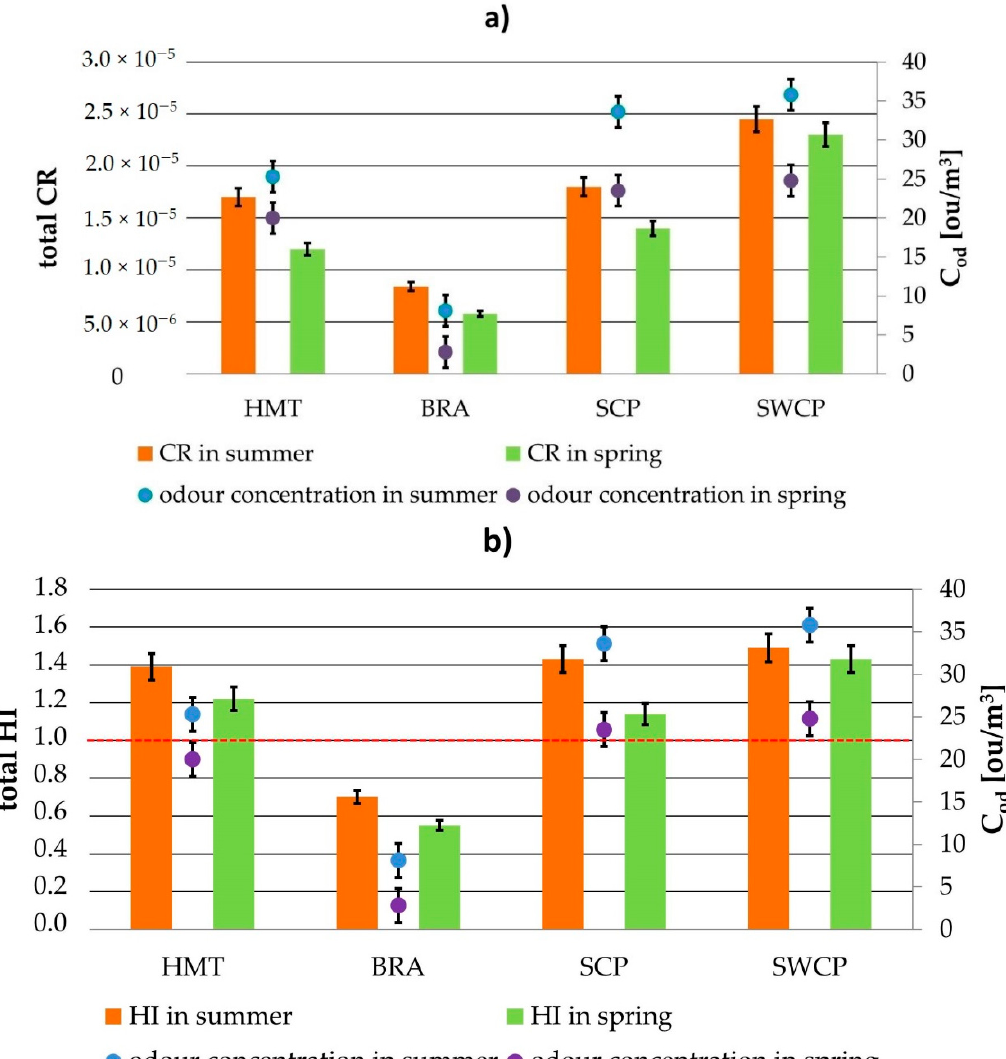
Figure 4. Total carcinogenic ( a ) and non-carcinogenic ( b ) risk in comparison to odour concentration values based on investigations performed in both 2017 and 2018.